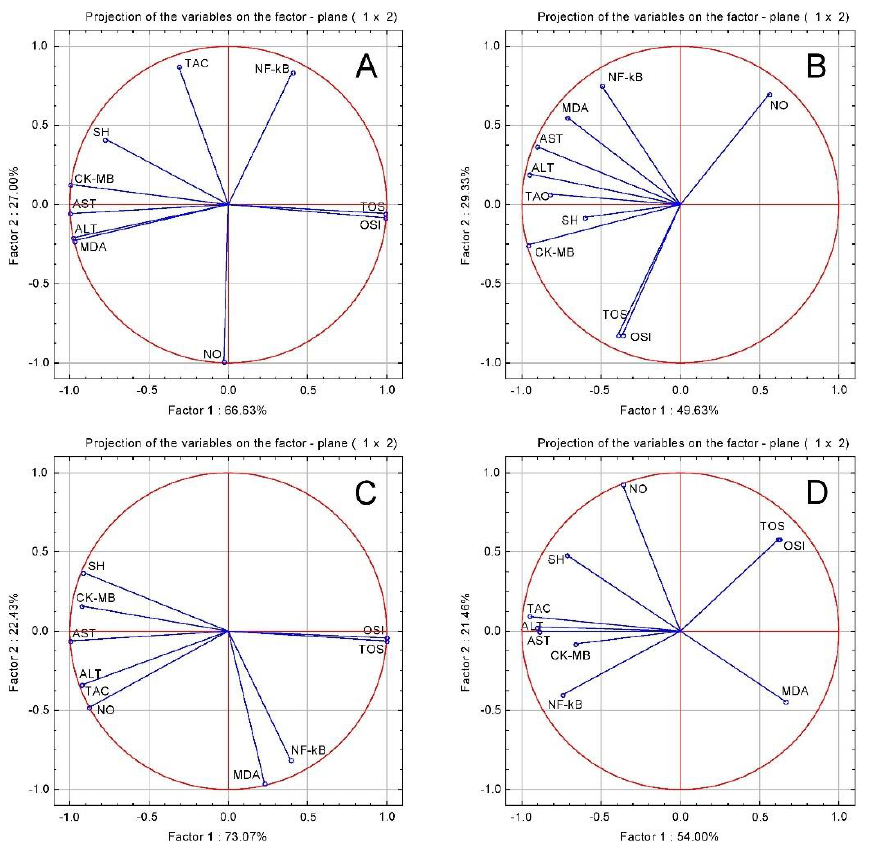
Figure 2. Oxidative stress tests and cardiac function tests PCA results: ( A ) ISO group; ( B ) CHT; ( C ) CHT 1:1; ( D ) CHT 1:3.